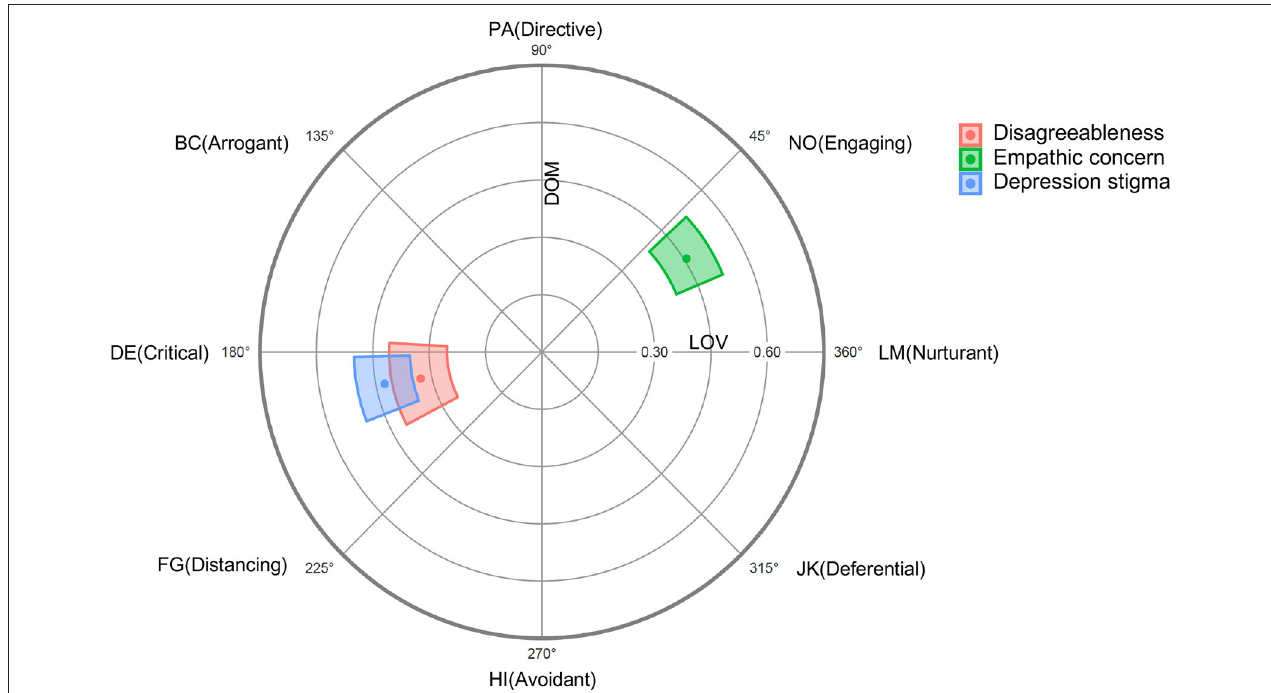
FIGURE 1 | Radar chart of Disagreeableness, Empathic concern and Depression stigma projected on to the SAS-C in Study 1. Dots represent mean values and coloured regions represent bootstrapped 95% confidence intervals [computed and plotted using the circumplex package for R; (67)].